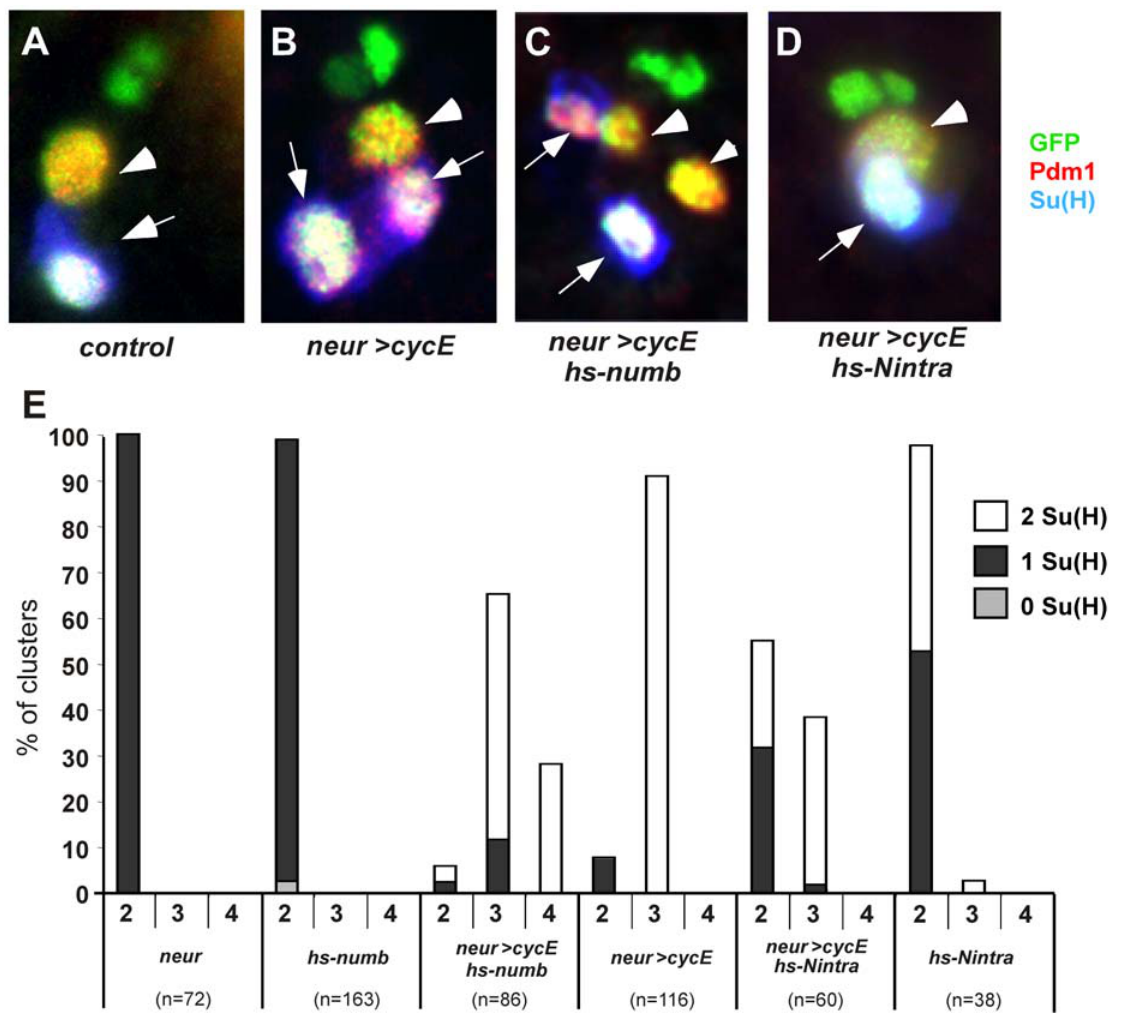
Figure 4. Activation of the Notch pathway prevents extra mitoses in the pIIa sublineage. (A–D) pIIa daughter cells are revealed by Pdm1 (red), socket cells by Su(H) (blue) and sensory cells by GFP immunoreactivity (green, UAS-H2B::YFP in all cases) in (A) control, (B) neur . CycE , (C) hs- numb , neur . CycE , and (D) hs-Nintra , neur . CycE . Pupae were heat shocked at 20 h APF and dissected after one night of recovery. Arrowheads indicate shaft cells and arrows socket cells. In (C), four pIIa daughter cells, amongst which two socket cells, are detected. (E) Histogram showing the percentage of clusters harbouring 2, 3, or 4 pIIa daughter cells in genotypes indicated on the abscissa. The percentage of clusters with no socket cell (grey bars) one socket cell (black bars), two socket cells (white bars) is